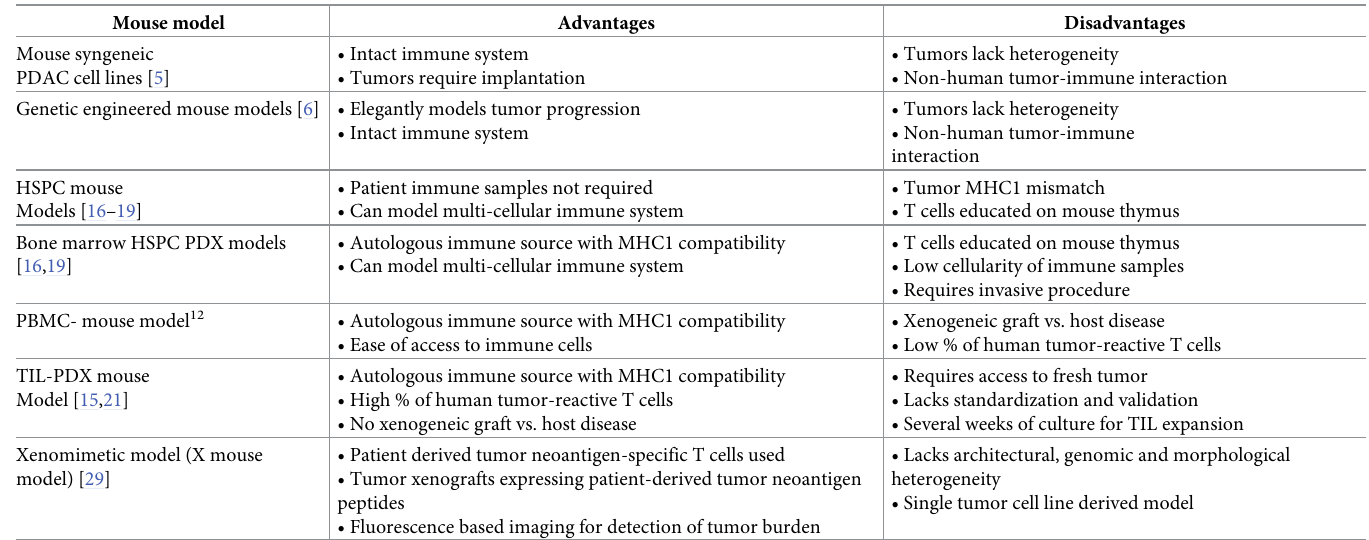
Table 1. Features of current state-of-the-art mouse models. Mouse